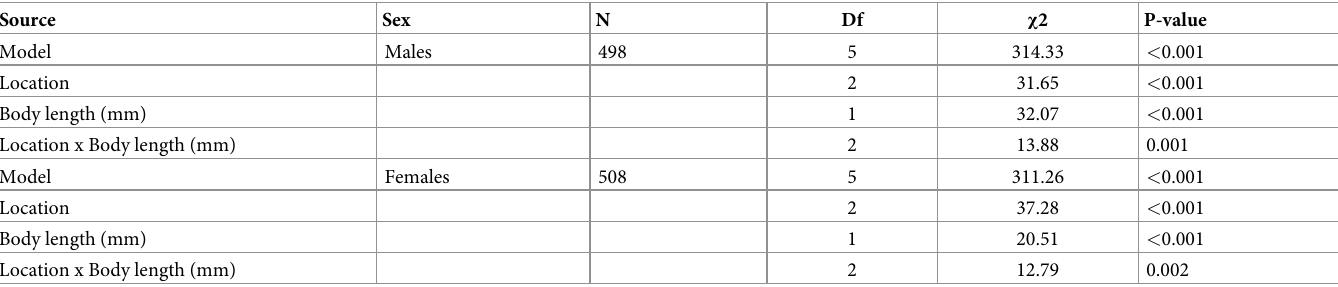
Table 2. Length at sexual maturity for males and females in sampling